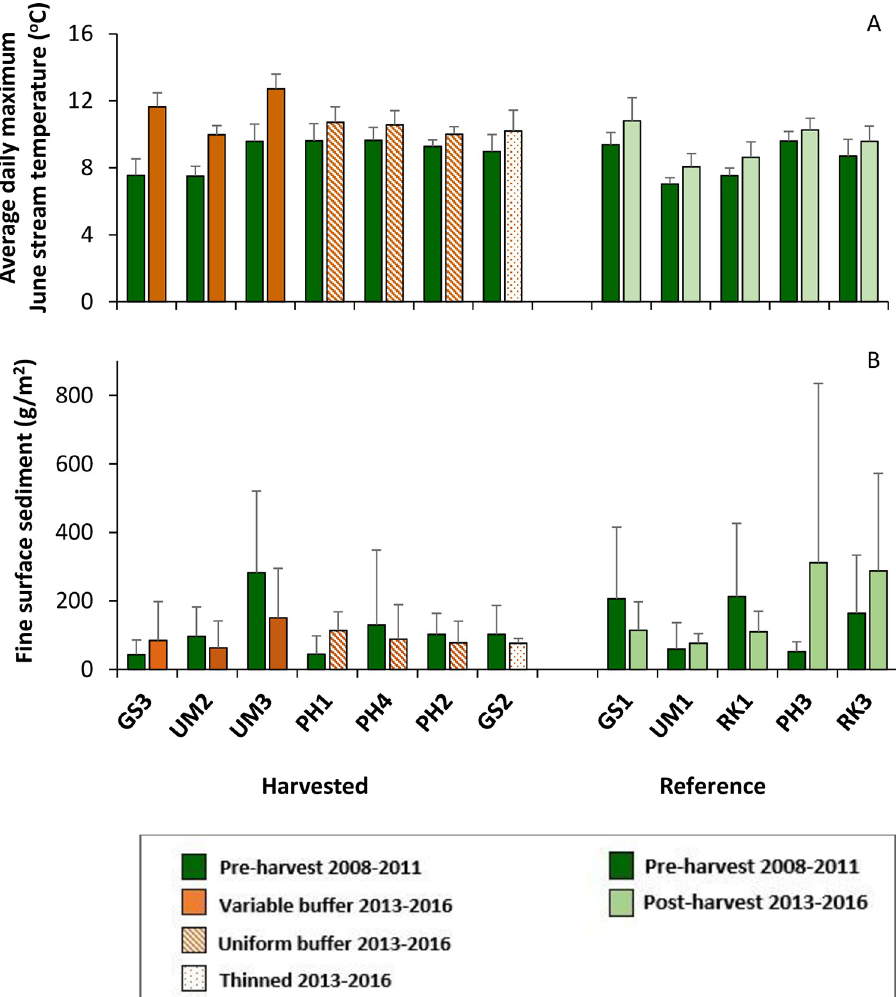
Fig 3. Stream temperature and fine surface sediment. Headwater sites are organized by harvest treatment and organized from left to right by the percentage of overstory light reaching the stream post-harvest. A) Average daily maximum stream temperatures in June during pre and post-harvest periods. B) Mass of fine surface sediment at annual sampling in June, for pre- and post-harvest periods. Bars show site averages and standard